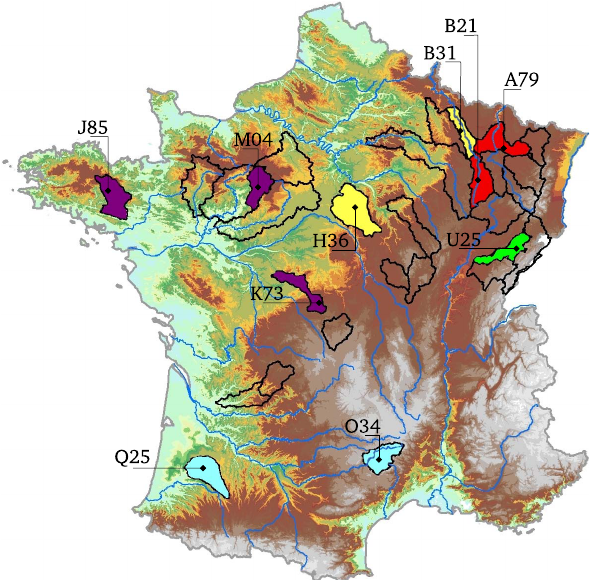
Fig. 2. Selected catchments are identified with the first three digits of each code used in Table 1. The other delimited basins are part of the study of results’ generalization shown in Brochero et al.